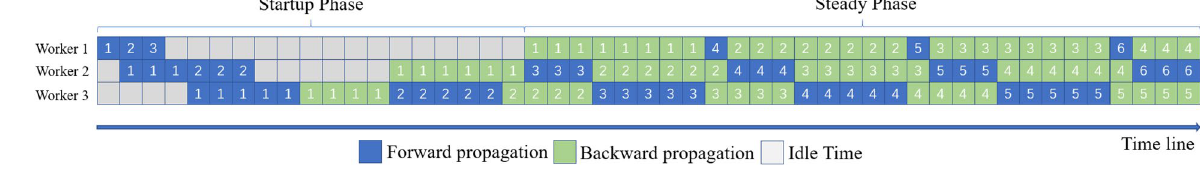
Fig. 6 An example of bi-partition with 1F1B